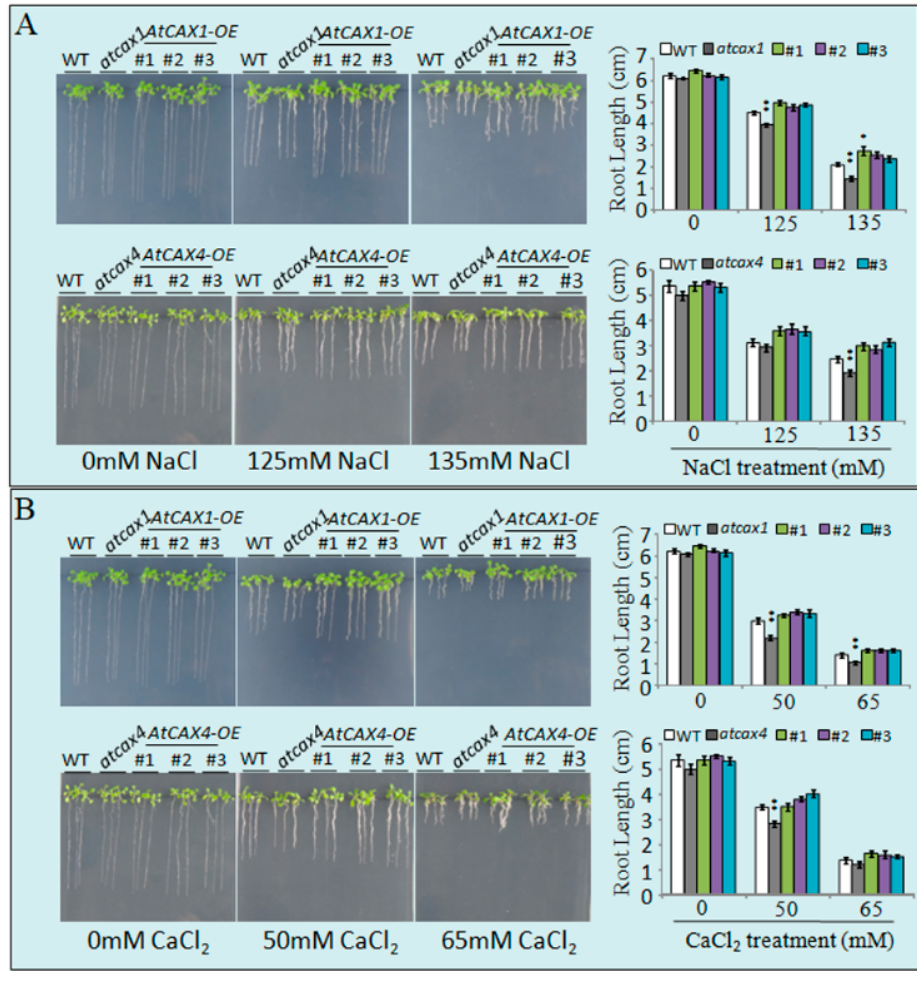
Figure 4. Stress tolerance analysis of AtCAX1 OE and AtCAX4 OE transgenic plants treated with different concentrations of salt and ion stress. Phenotypes of WT, atcax1 , atcax4 , and AtCAX1 OE and AtCAX4 OE transgenic seedlings treated with 125 or 135 mM NaCl ( A ), 50 or 65 mM CaCl 2 ( B ). Photographs were taken 3 weeks after germination. The root length of WT, atcax1 , atcax4 , and AtCAX1 OE and AtCAX4 OE transgenic plants were measured 3 weeks after treatment. Data represent the mean ± SE of three replicates. Single and double asterisks indicate significant differences from WT at p < 0.05 and p < 0.01, respectively.